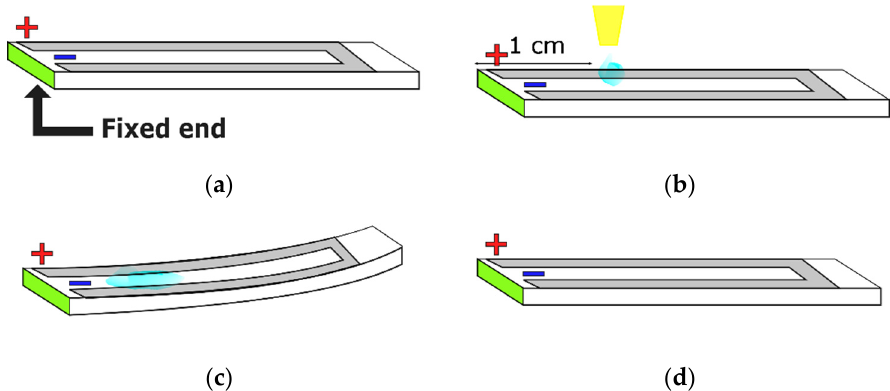
Figure 1. Schematic of the actuation principle: ( a ) Initial position; ( b ) Activation by volume solution; ( c ) Movement induced by hygroexpansion; ( d ) Deactivation/deswelling induced by current heating; return to initial position.